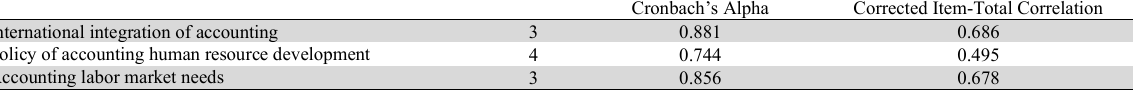
Results of analysis of Determinants Confidence of Scales in the